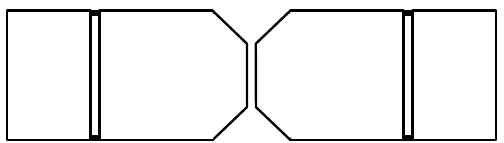
Figure 4. This is typical Bow-tie antenna geometry, the wideband of antenna depends on the cone angle β of triangle fins and the working frequency of antenna depends on its length L .